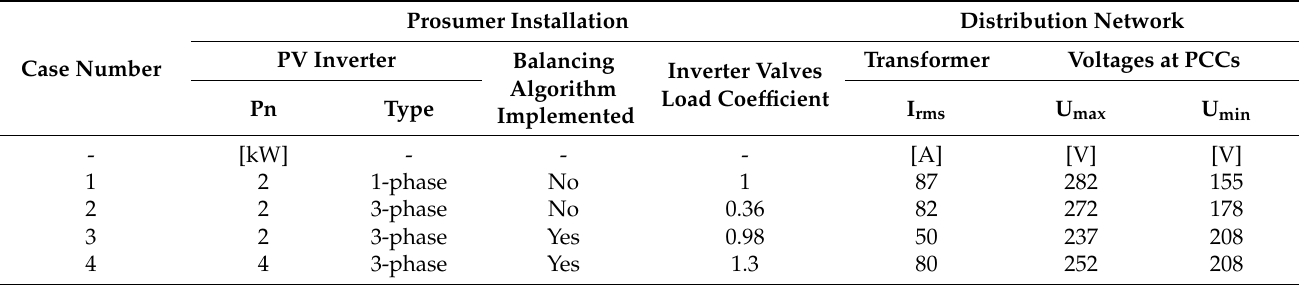
Table 1. Comparison of simulation